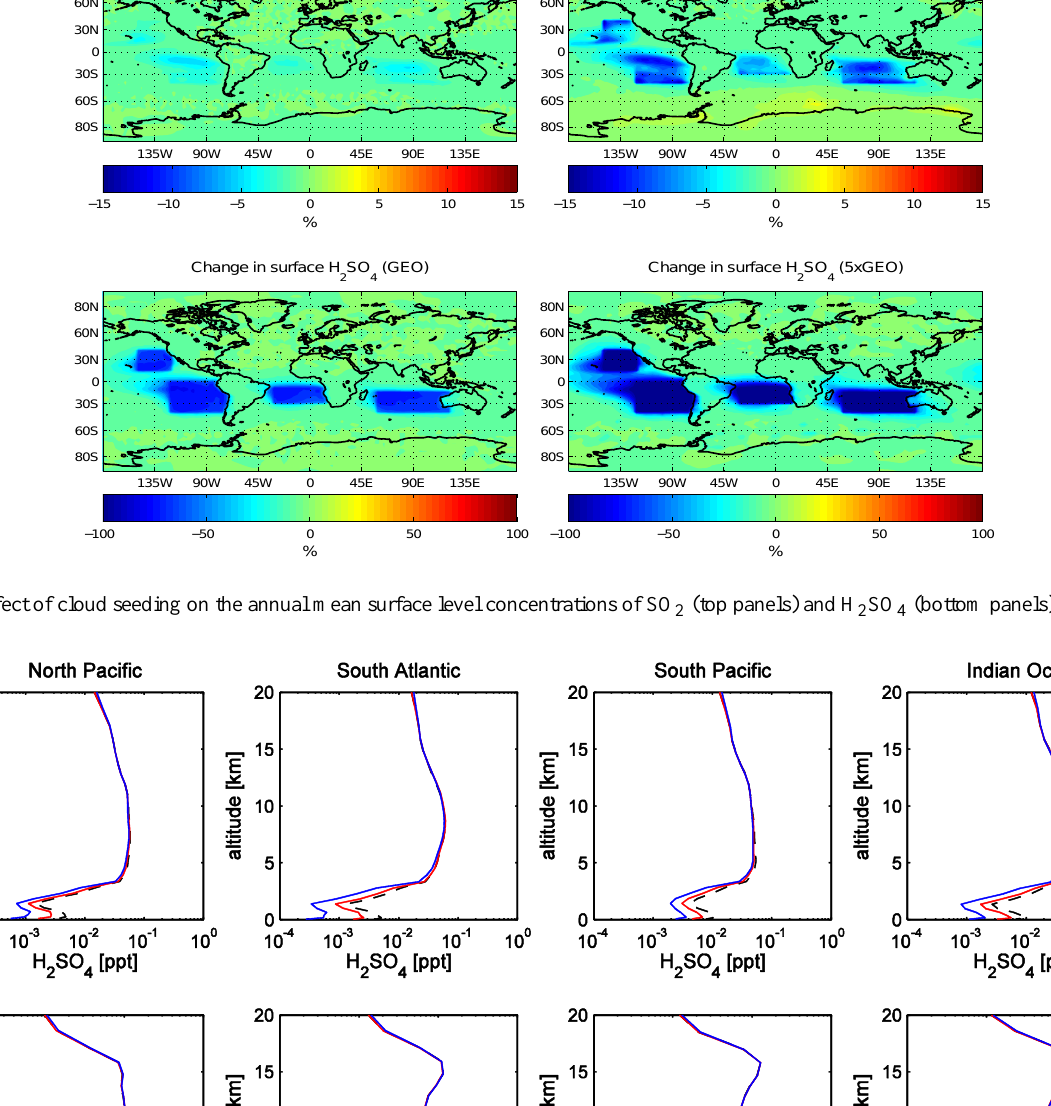
SO (top panels) 2 4